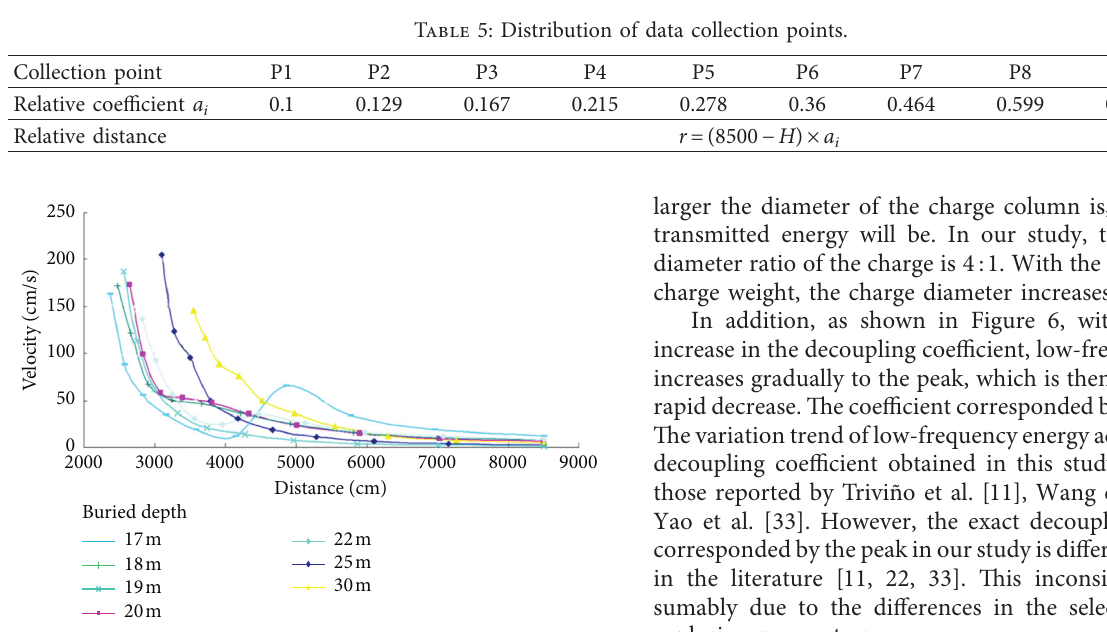
Figure 5: Attenuation principle of the seismic source wavelet in marine carbonate.